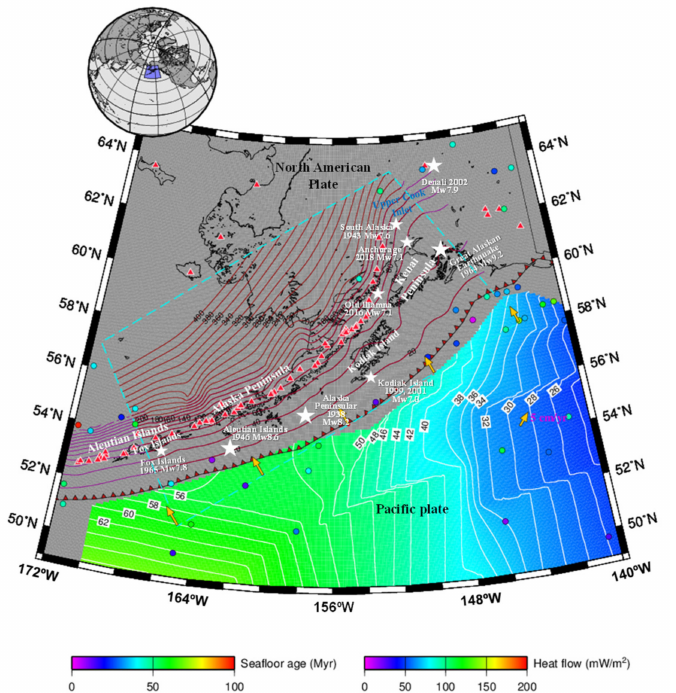
Figure 1. Study region in Alaska. Seafloor age and surface heat flow observations in Alaska are included. The colored solid circles represent the observed surface heat flow obtained from the global heat flow database [19]. The ocean seafloor age and its distribution are provided by EarthByte [15]. The light blue dotted line indicates the model boundary. The red (inside the model region) and purple (outside the model region) curves represent iso-depth contours of the upper surface of the subducted oceanic plate, with two adjacent lines separated by 20 km (Slab2)